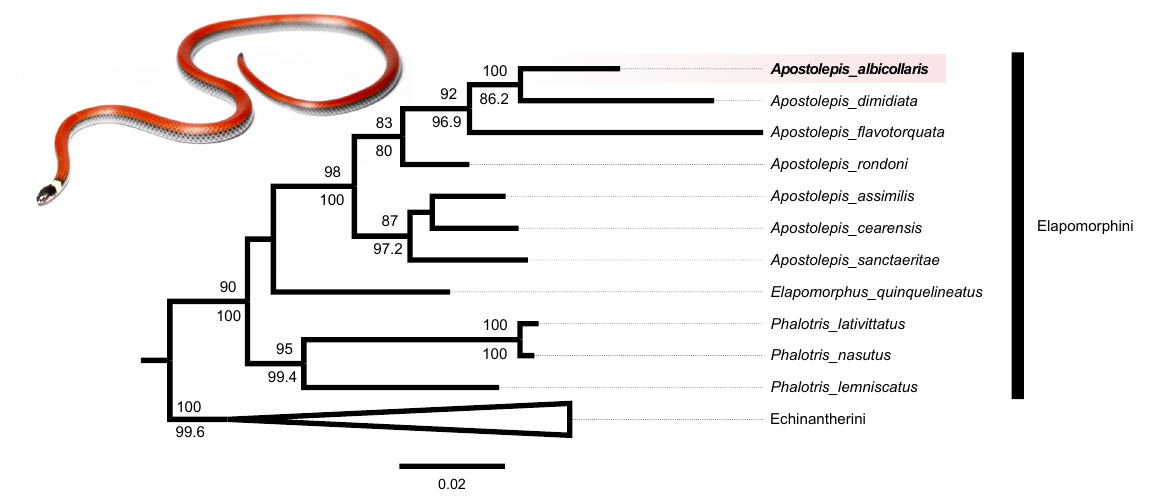
Fig. 8. Consensus topology of Apostolepis Cope, 1862 BI and ML phylogenetic relationships, support given in Bootstrap (top, > 80) for maximum likelihood inference and Consensus Support (bottom, > 80) for Bayesian inference. Scale bar = molecular distance. Inset photograph: Apostolepis albicollaris Lema, 2002 by Luís Felipe Carvalho de